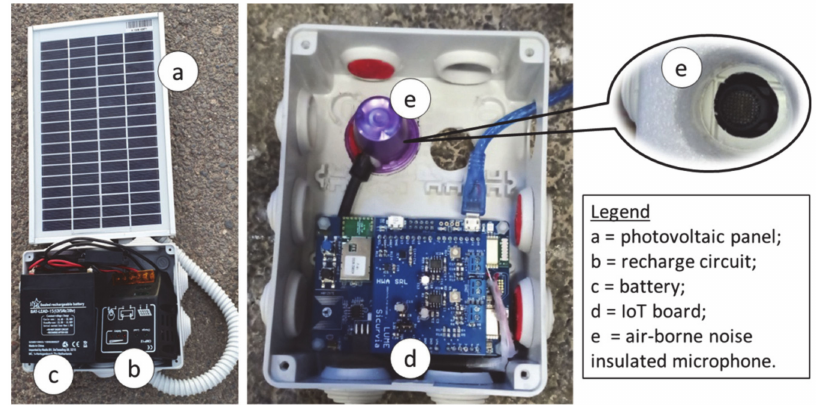
Figure 1. First prototype of the wireless sensing node of the proposed